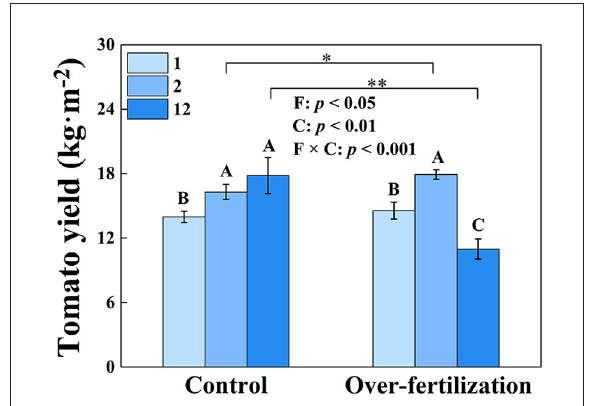
FIGURE1 Effects of fertilization on tomato yield. Values are means ± SD ( n = 3). * and ** indicate significant differences between fertilization under the same cropping duration at p < 0.05 and p < 0.01, respectively. Different letters (A, B, and C) above the bars indicate significant ( p < 0.05) differences between cropping durations under the same fertilization treatments. F, fertilization; C, cropping